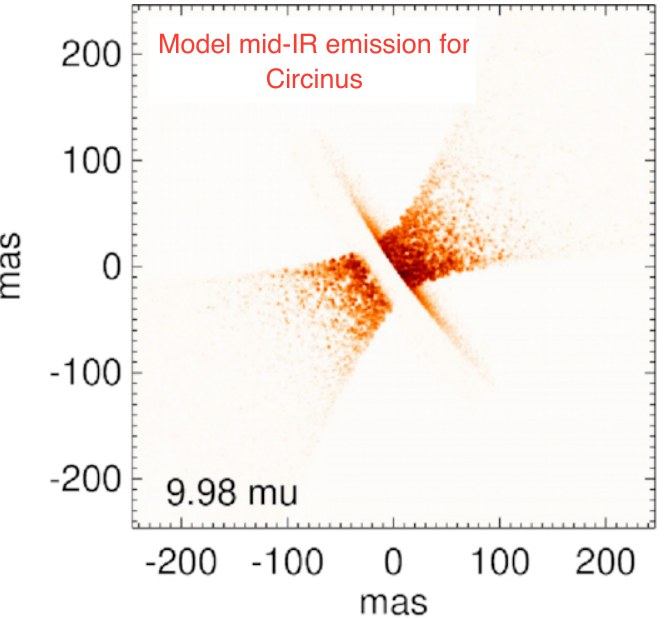
Figure 10. A model for the mid-IR emission of the Circinus galaxy constrained by both mid-IR pc-scale interferometric observations with VLTI/MIDI as well as the global SED. This is the best-fit model which is a thin disk, consisting of a mixture of graphites and silicates (accounting for the absorption seen in this 10 µ m model), plus a hollow hyperboloid, consisting of predominantly ∼ graphites. This model is consistent with the very recent VLTI/MATISSE high-resolution imaging of Circinus presented in Isbell et al. [138]. Reproduced from Stalevski et al. [137] with permission from the